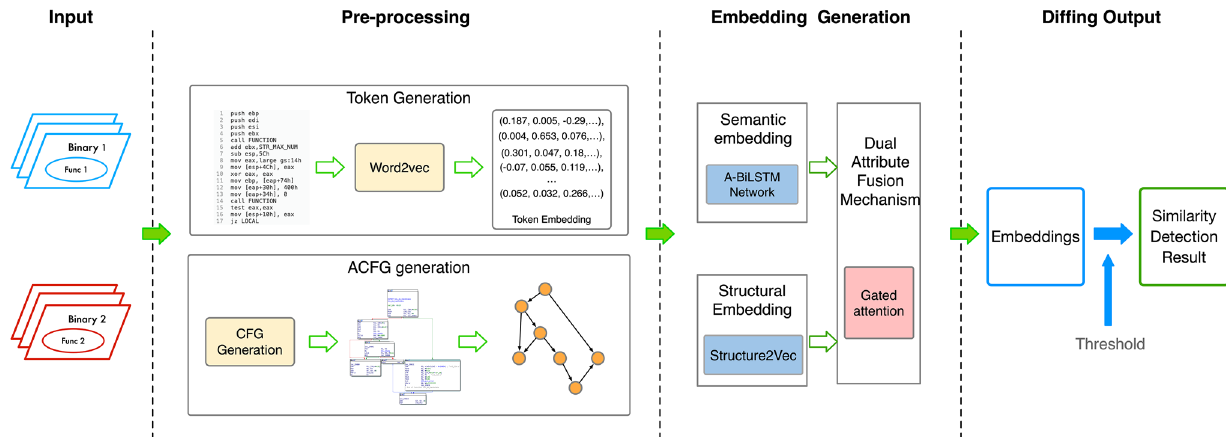
Fig. 2 Overview of the DeepDual-SD